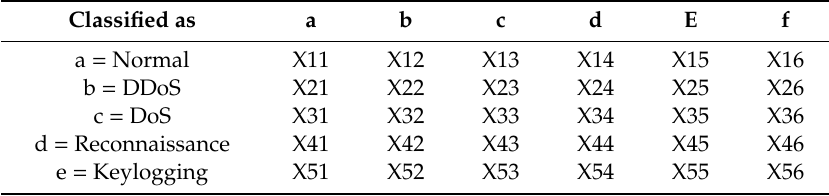
Table 6. Confusion matrix to evaluate the performance of our proposed